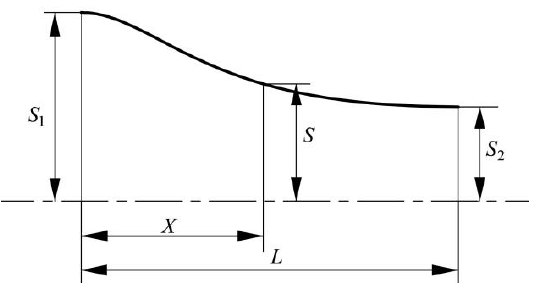
Figure 7. Schematic diagram of shrinkage curve: S 1 is the inlet radius, L is the nozzle length, S 2 is the outlet radius, X is a variable that varies from 0 to L ; S is a variable that varies from S 1 to S 2 . The curves of the three curve equations were depicted by MATLAB software (The Mathworks, Natick, MA, USA), as is shown in Figure 8. By comparison, it was found that, in the inlet section, the Witoszynski curve shrunk faster and the straight line and bicubic curve were gentler. In the outlet section, the Witoszynski curve and the bicubic curve were flatter than the straight line and the Witoszynski curve was the